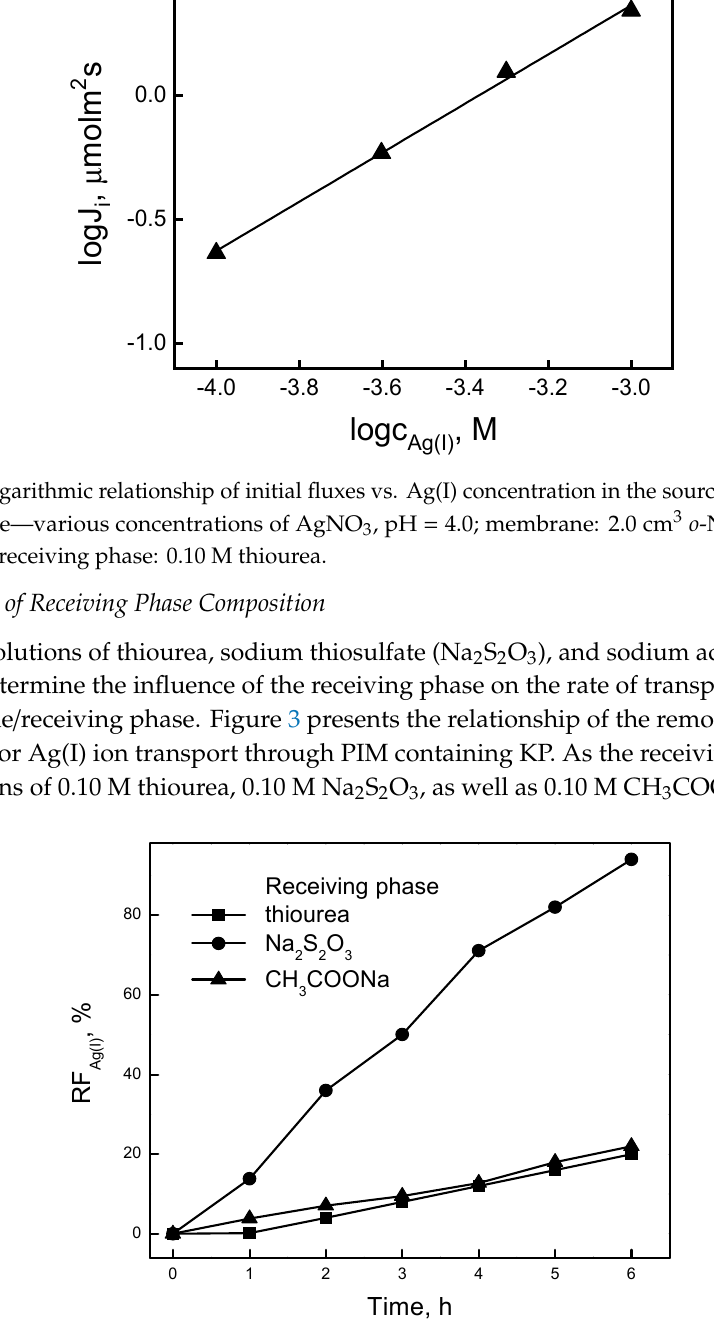
Figure 3. The removal factor ( RF ) obtained for the transport of Ag(I) ions across the polymer inclusion membrane (PIM). Source phase—1.0 × 10 − 3 M AgNO 3 , pH = 4.0; membrane: 2.0 cm 3 o -NPPE/1.0 g CTA; 0.050 M KP, receiving phase—0.10 M Na 2 S 2 O 3 ; 0.10 M thiourea and 0.10 M CH 3 COONa .